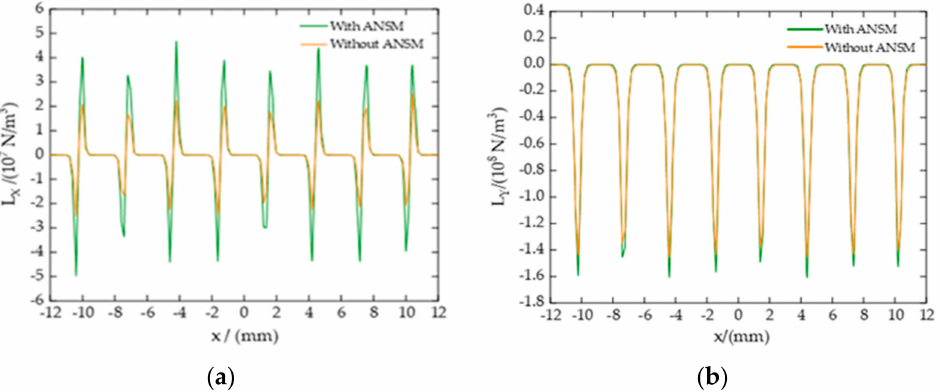
Figure 11. The Lorentz force density on the surface of an aluminum plate at t = 6 µ s. ( a ) The Lorentz force density on an aluminum plate surface in the X -direction and ( b ) the Lorentz force density on aluminum plate surface in the Y -direction. Based on the orthogonal optimization model, the green line represents the Lorentz force density after ANSM is applied in the model, and the yellow curve represents the Lorentz force density without